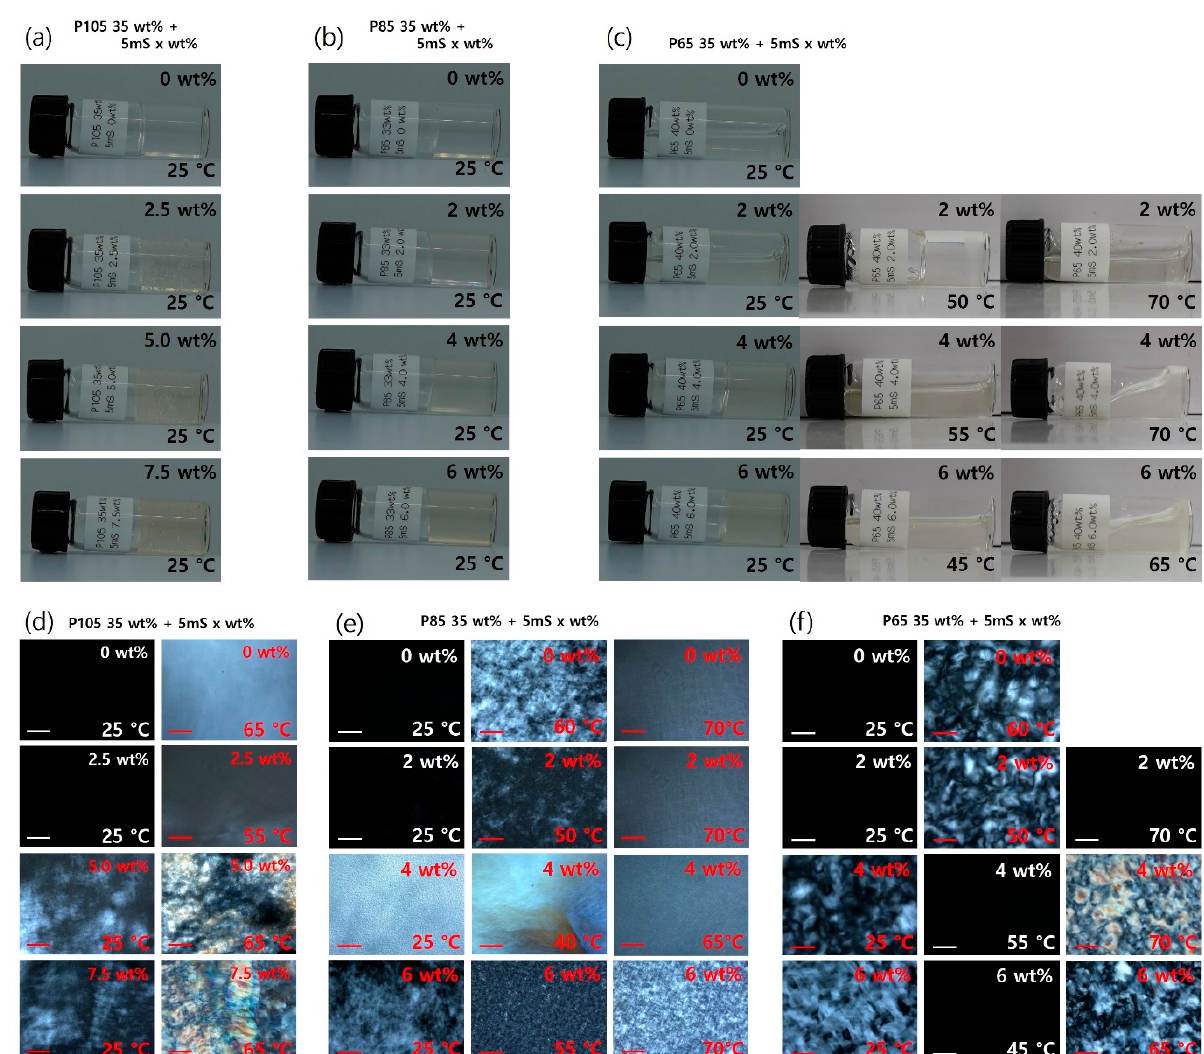
Figure 1. Visual inspection of the Pluronic block copolymer-5mS complexes at different temperatures: ( a ) P105-5mS complexes at 25 °C, ( b ) P85-5mS complexes at 25 °C, and ( c ) P65-5mS complexes at 25 °C and 45–70 °C). Polarized optical microscopy (POM) images at different temperatures under the crossed polarizer condition: ( d ) P105-5mS complexes at 25, 55, and 65 °C, ( e ) P85-5mS complex at 25 °C and 40–70 °C, and ( f ) P65-5mS complex at 25 °C and 45–70 °C). The scale bar in ( d – f ) is 100 μ m.